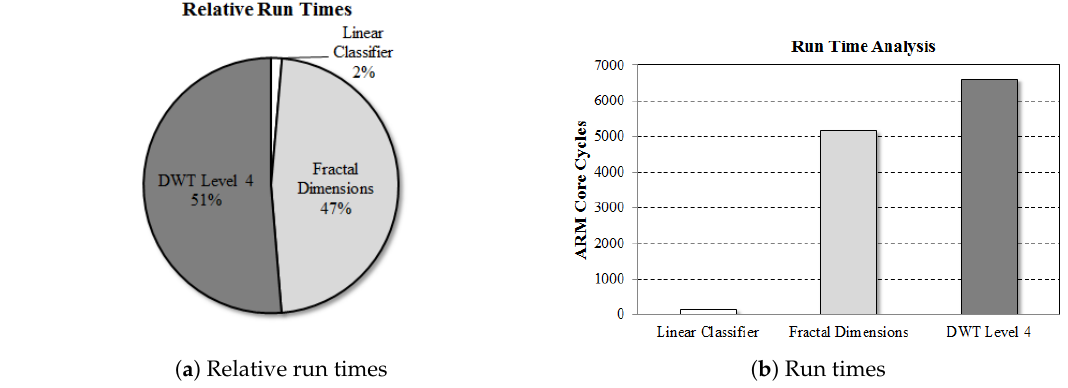
Figure 5. Run time analysis of the proposed